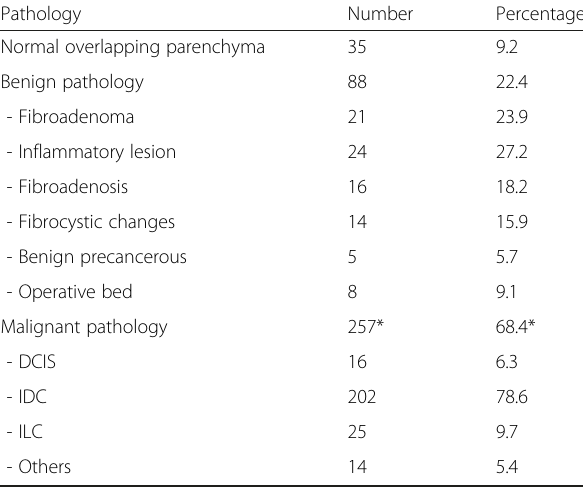
Table 1 Classification of the 380 breast asymmetries according to histopathology results and outcome of follow-up studies